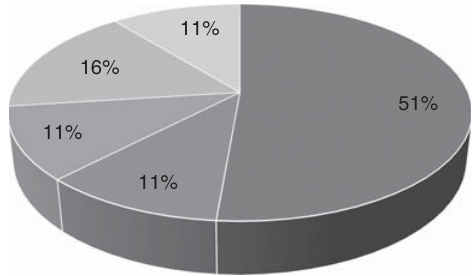
Figure 1. Research methods